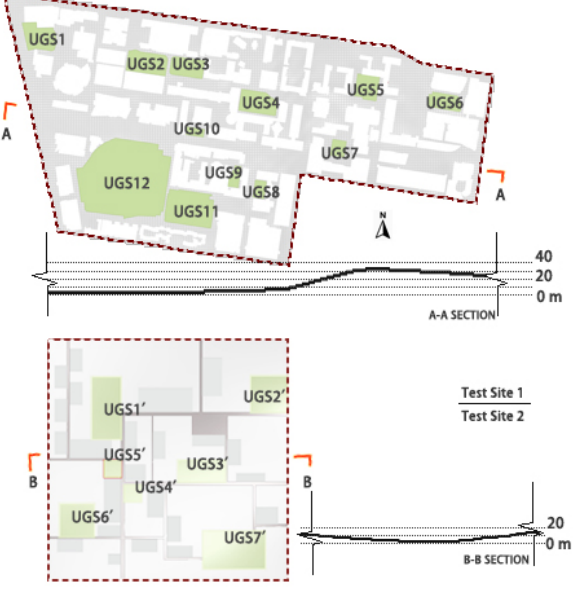
Figure 5. Simulation Site